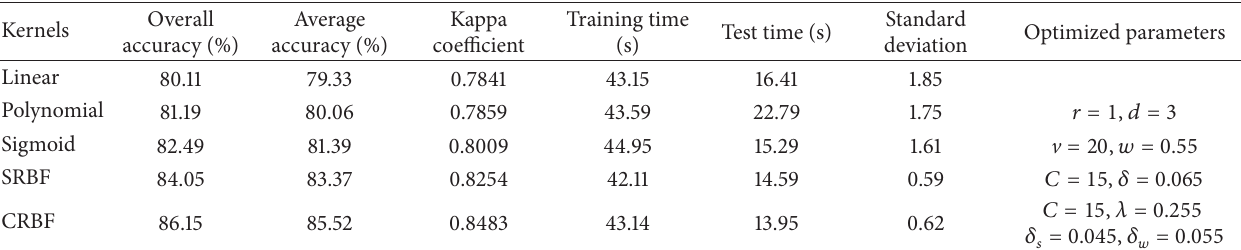
Table 7: Comparison of BDT-SMO classification approaches under different kernels (zone 2).